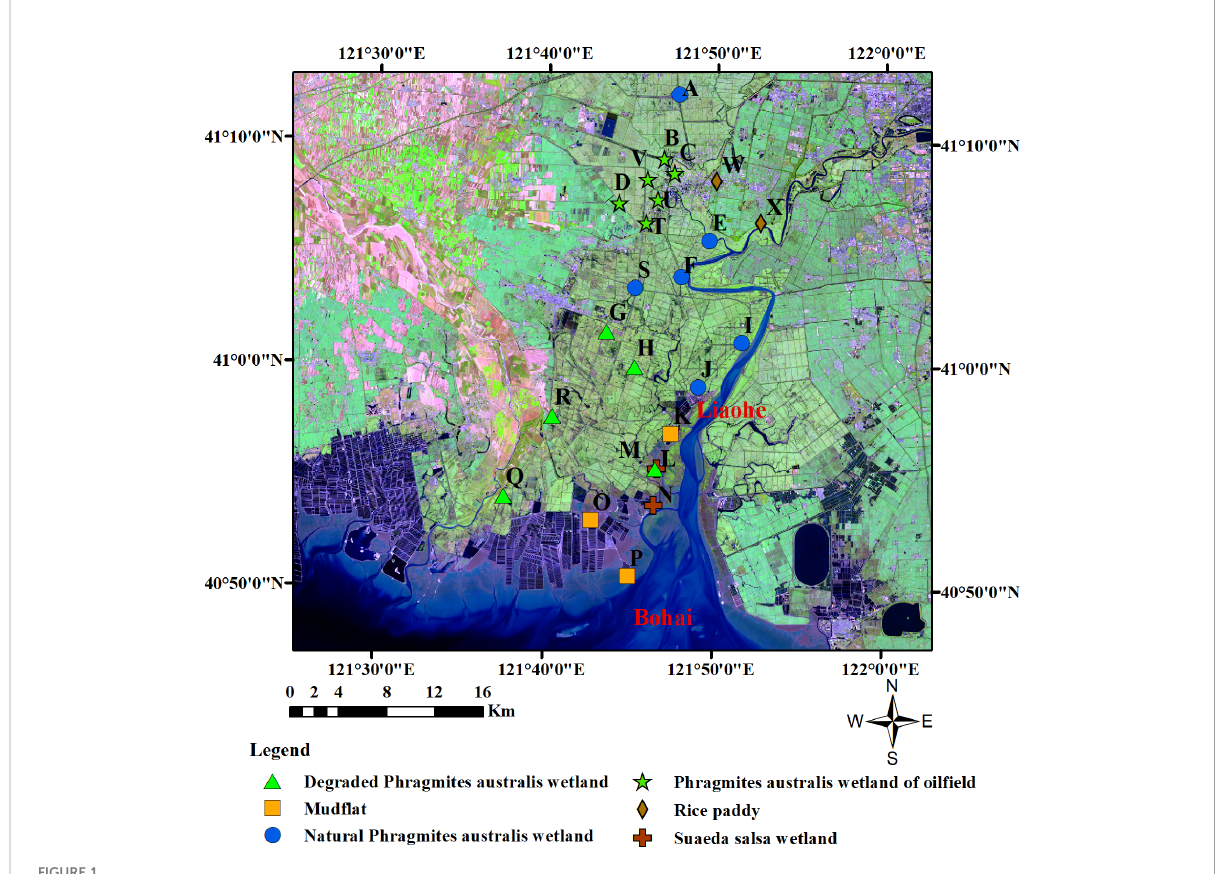
FIGURE 1 Sampling sites in the Liaohe